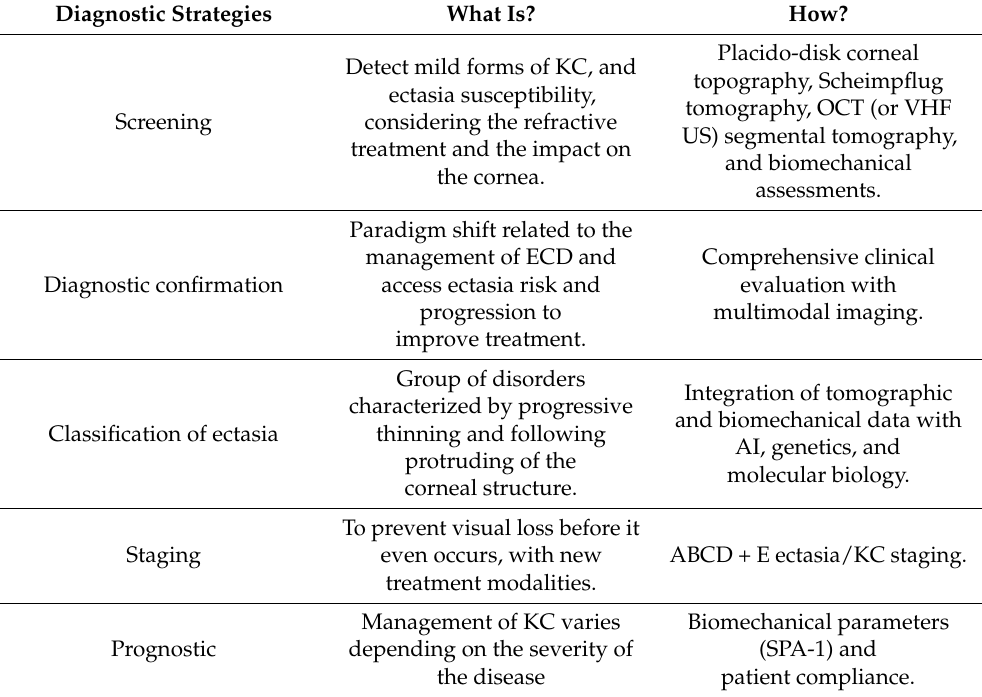
Table 1. Diagnostic strategies in